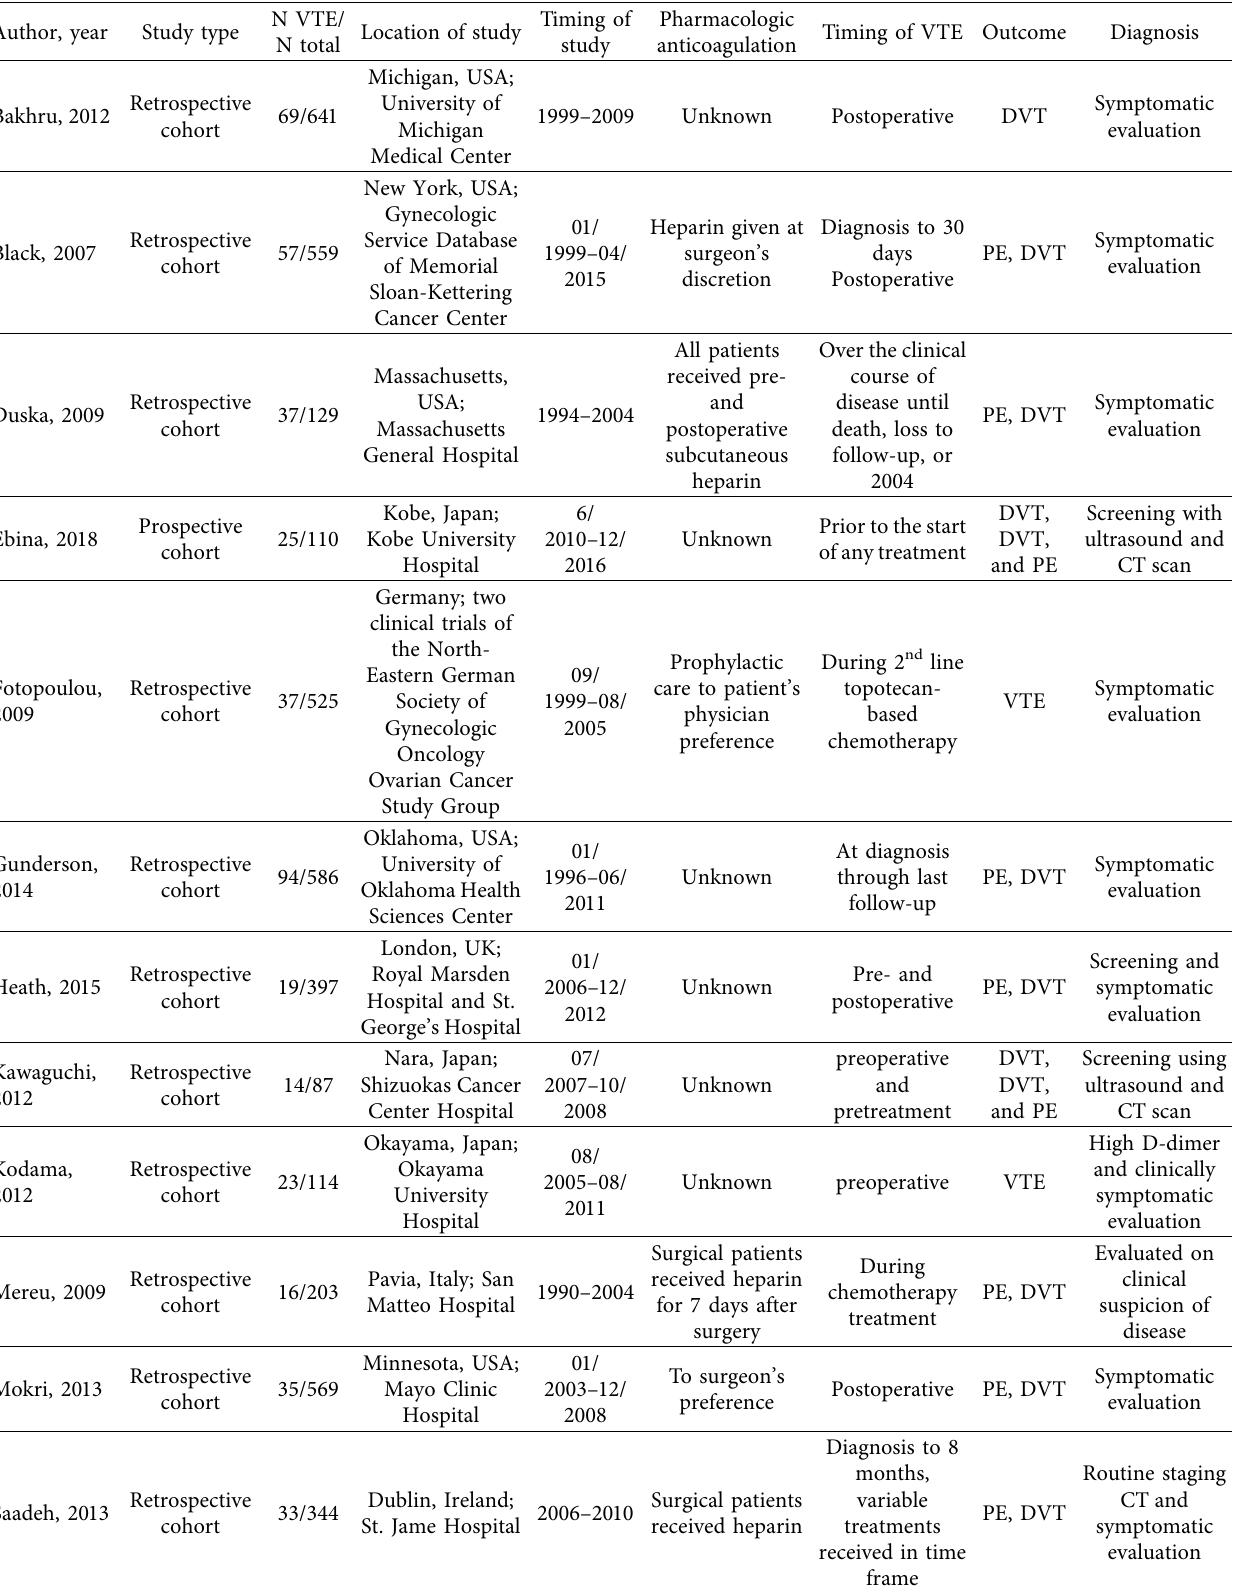
Table 1: Description of the included